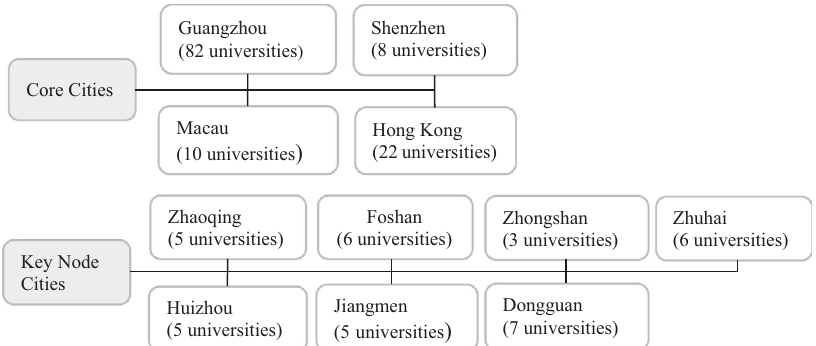
Fig. 4 Distribution of universities in the GBA. Source based on Ministry of